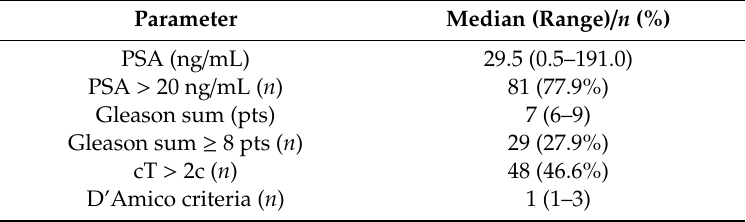
Table 1. Clinical characteristics of prostate cancer patients participating in the study ( n = 104).